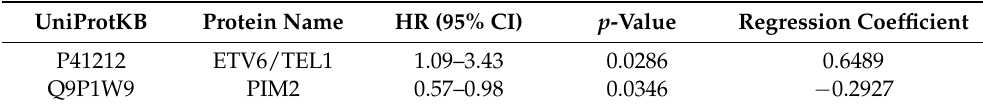
Table 3. Proteins selected as prognostic factors in the stepwise multivariate survival analysis per- formed by Cox proportional hazards